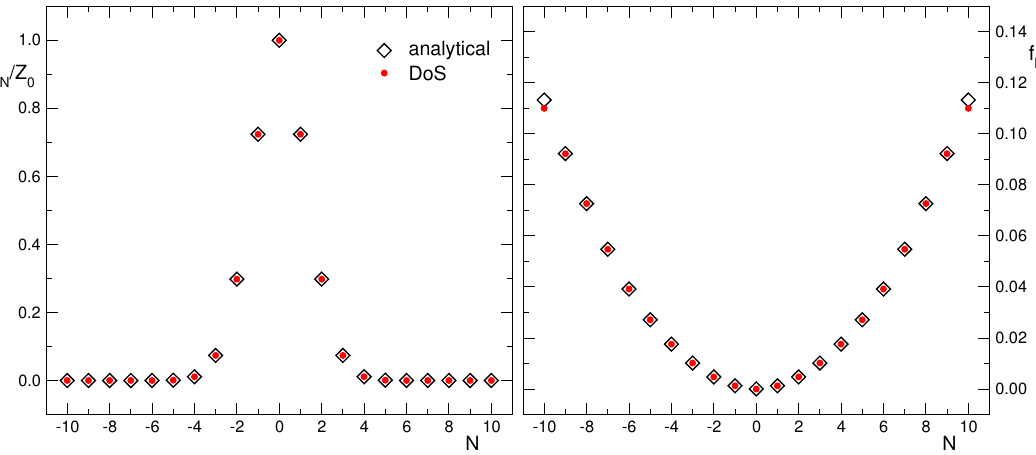
Figure 2. The canonical partition sums Z N / Z 0 (lhs) and the corresponding free energy densities f N = − ln ( Z N / Z 0 ) / V (rhs) as a function of the net fermion number N . The parameters are V = 16 × 16 with m = 0.1, and we compare the results from the CanDoS determination (red dots) to the analytic results obtained with Fourier transformation (black